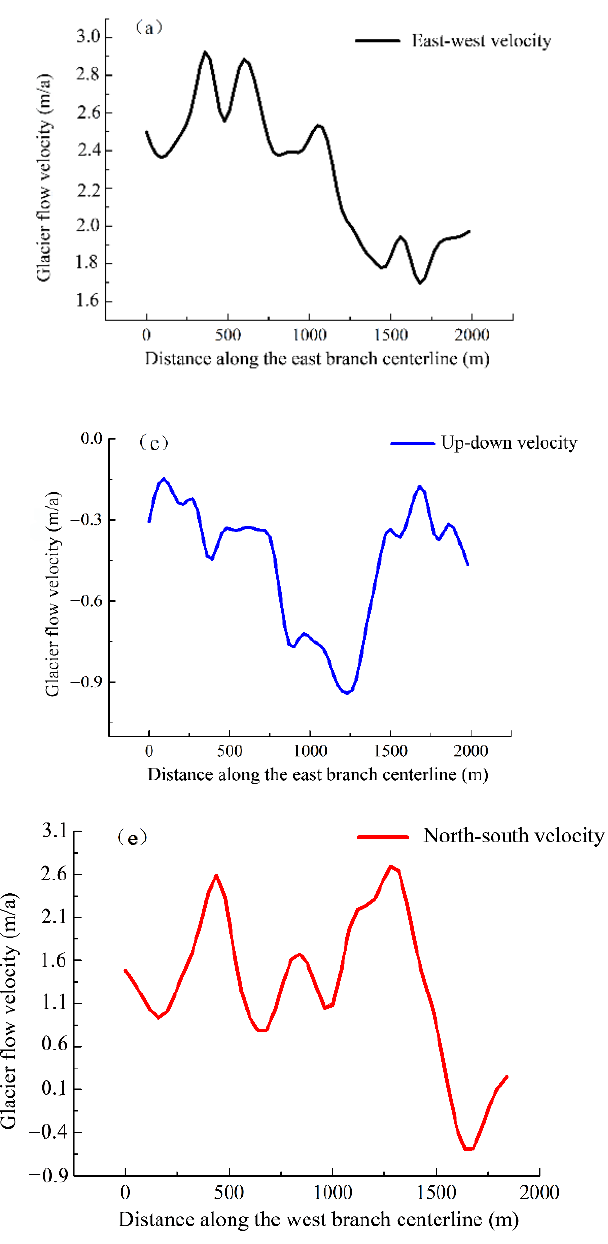
Figure 8. Glacier flow velocity along the centerlines during 2016 – 2017. ( a – c ) Show the velocity in the eastern branch. ( d – f ) Show the velocity in the western branch.